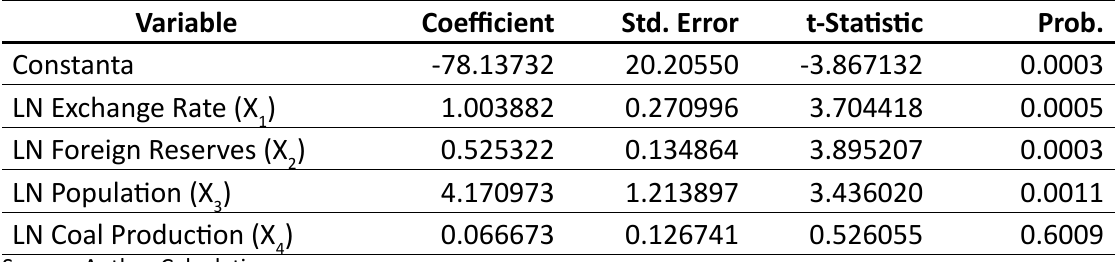
Table 4: Result of Regression Estimated of Panel Data by Fixed Effect Model Variable Coefficient Std. Error t-Statistic